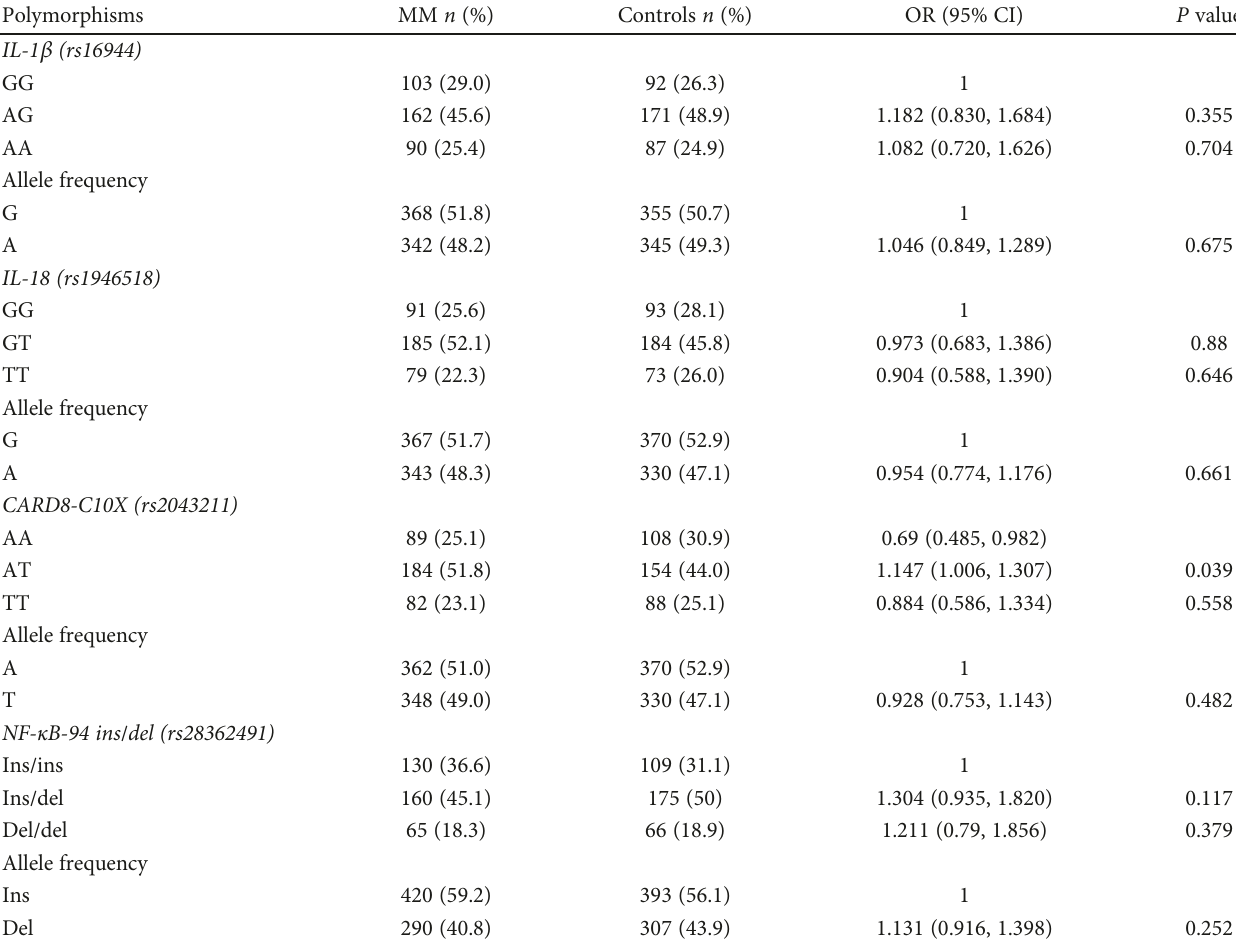
Table 3: Genotype distribution of the di ff erent polymorphisms and their association with MM